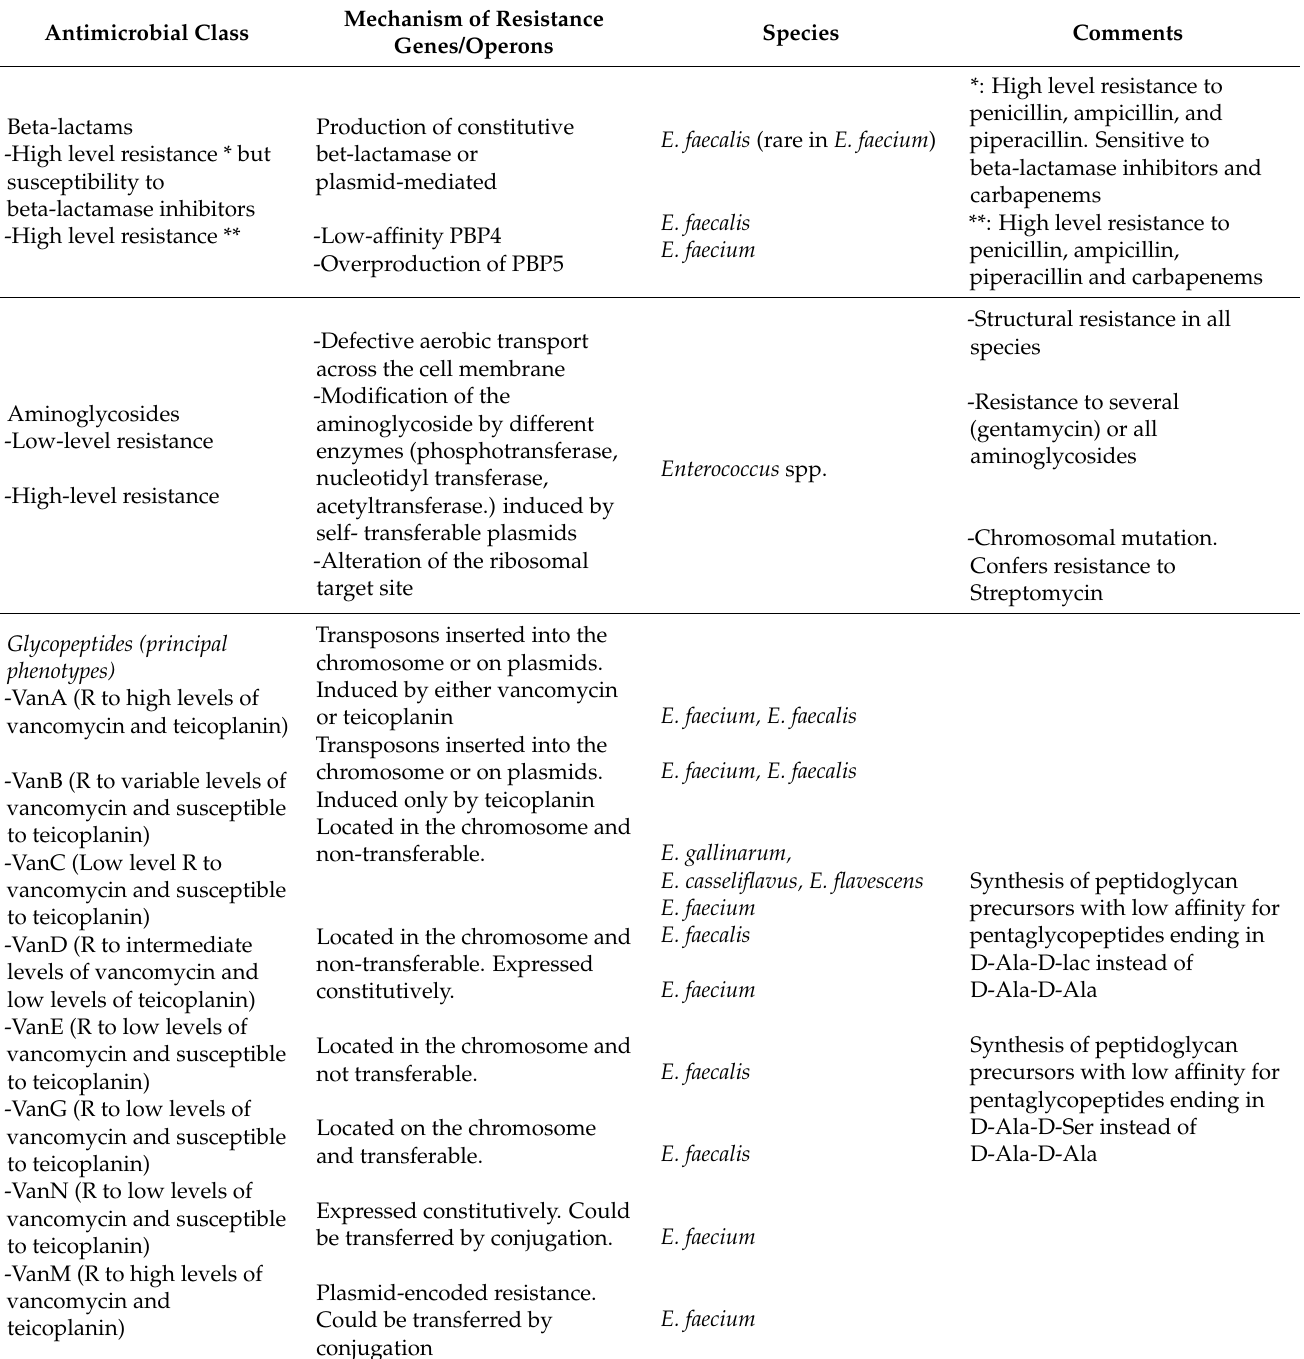
Table 1. Antimicrobial resistance in